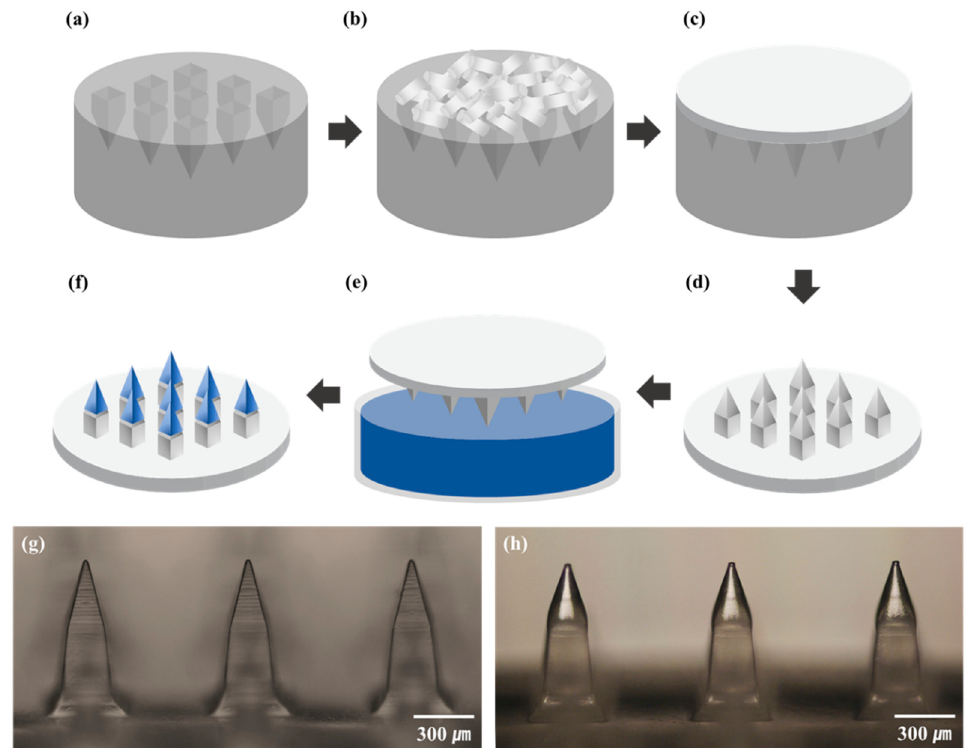
Figure 1. Fabrication process and results. ( a ) polydimethylsiloxane (PDMS) mold preparation, ( b ) polylactic acid (PLA) pellet loading, ( c ) PLA melt casting, ( d ) PLA microneedle demolding, ( e ) dip coating, ( f ) drying, ( g ) PLA microneedles, and ( h ) vaccine-coated microneedles.